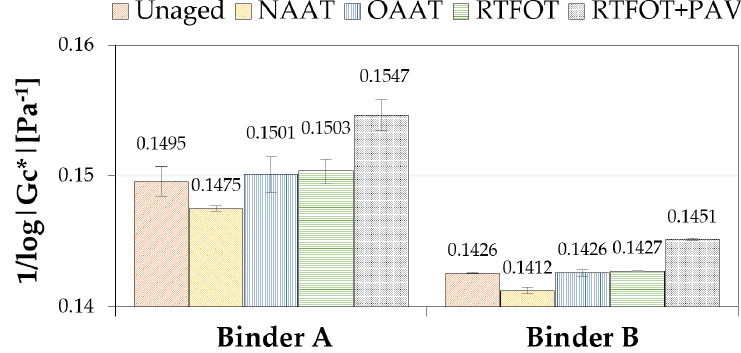
Figure 5. Values of the inverse of log crossover modulus for binders A and B.